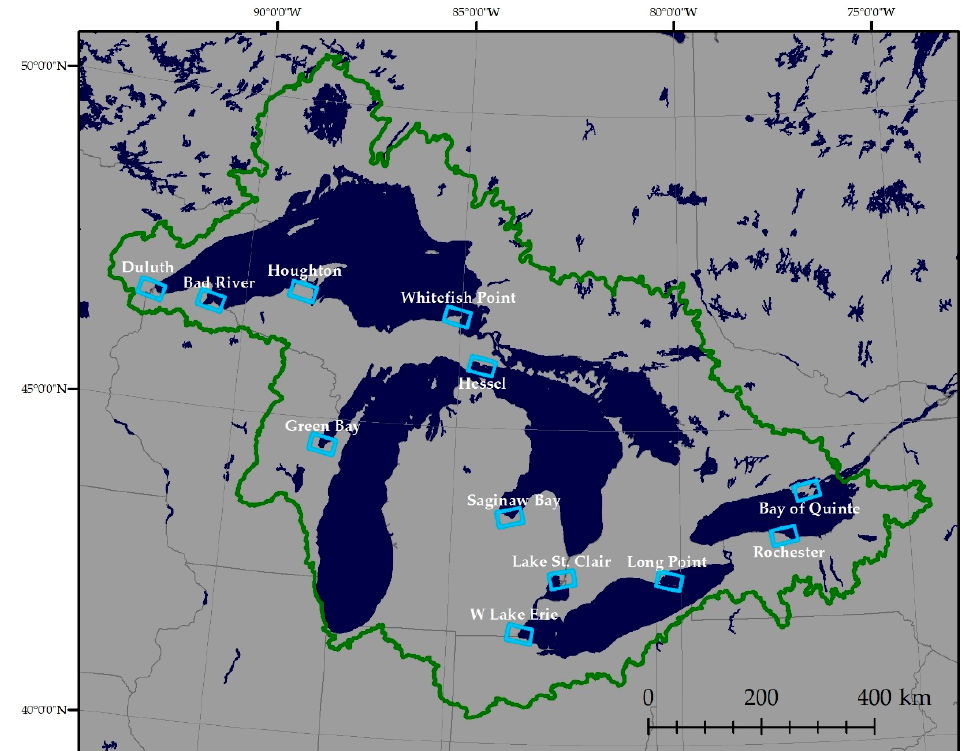
Figure 1. GLRI RADARSAT-2 Pilot Sites as blue rectangles. Great Lakes Basin is outlined in green where DigitalGlobe—MAXAR submeter optical imagery are being acquired.